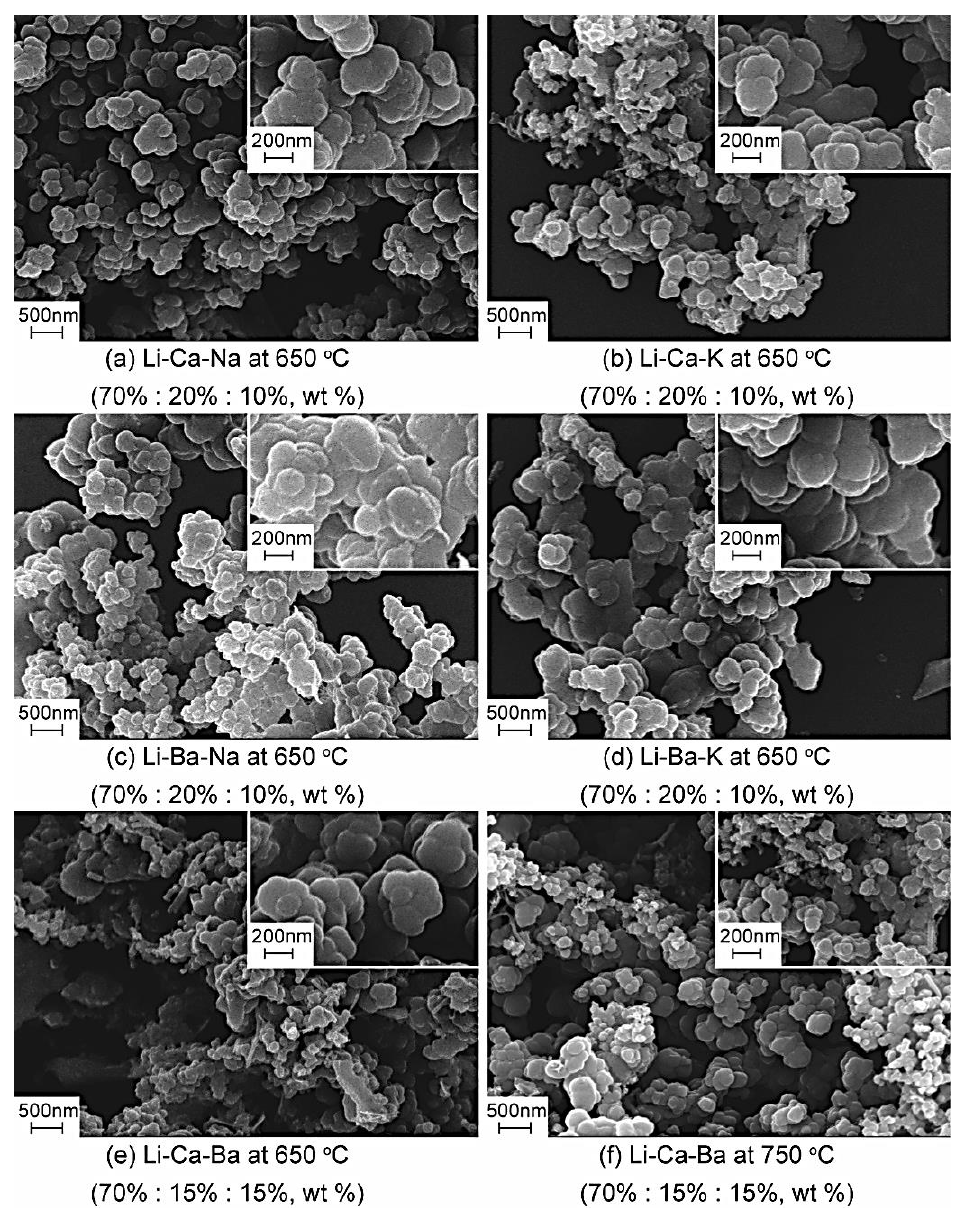
Figure 4. Carbon spheres obtained from different molten eutectic carbonates.